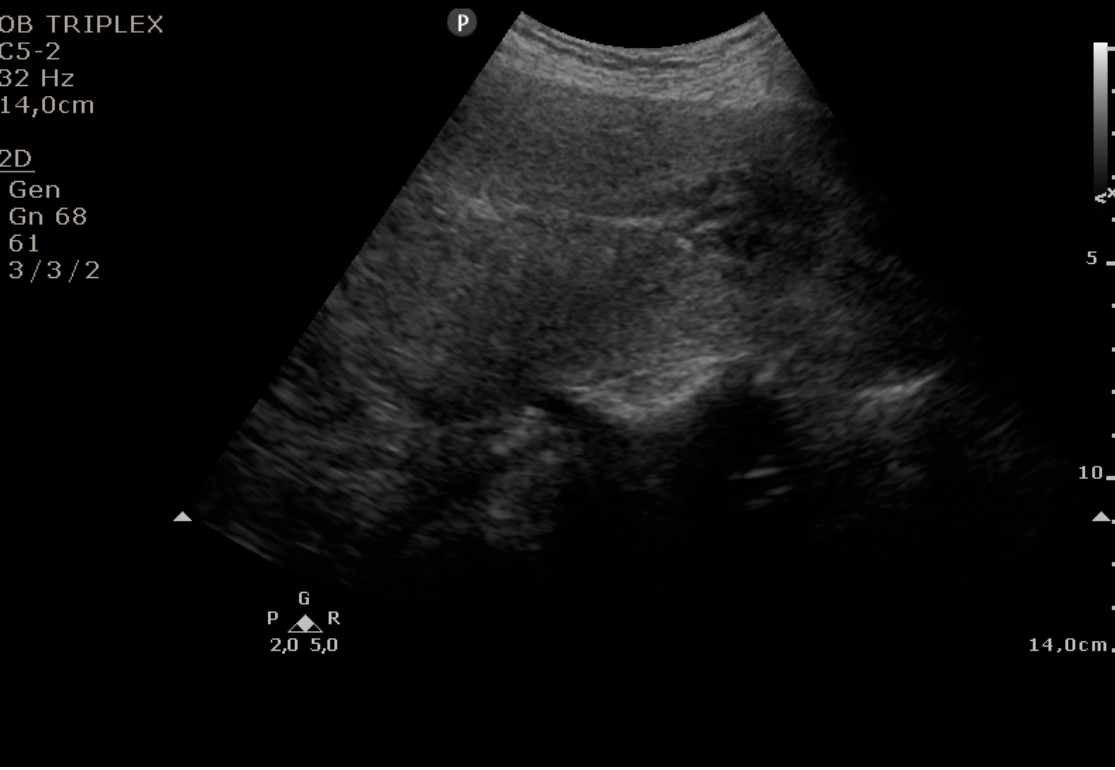
Figure 4. Grade 3: less than three-quarters of the endometrial length occupied by blood or debris.